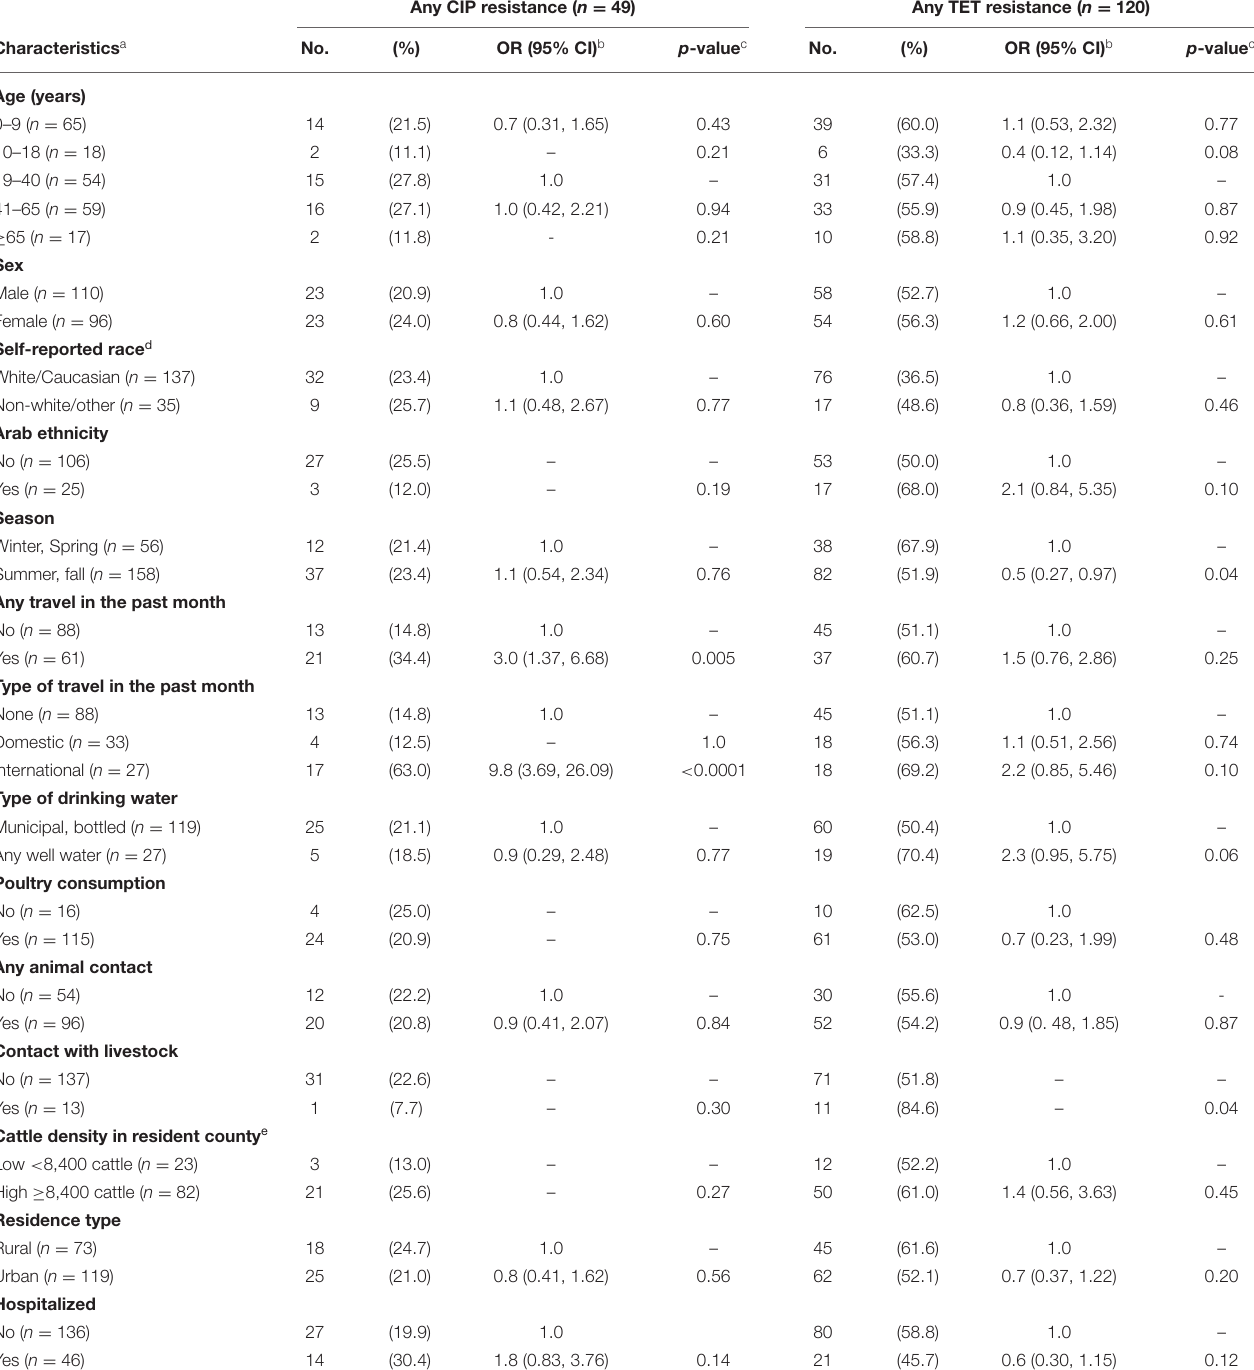
TABLE 1 | Univariate analysis to identify factors associated with any ciprofloxacin resistance (CIP) and any tetracycline resistance (TET) among 214 Campylobacter jejuni isolates from Michigan, 2011 to 2014. Any CIP resistance ( n = 49) Any TET resistance ( n = 120) Characteristics